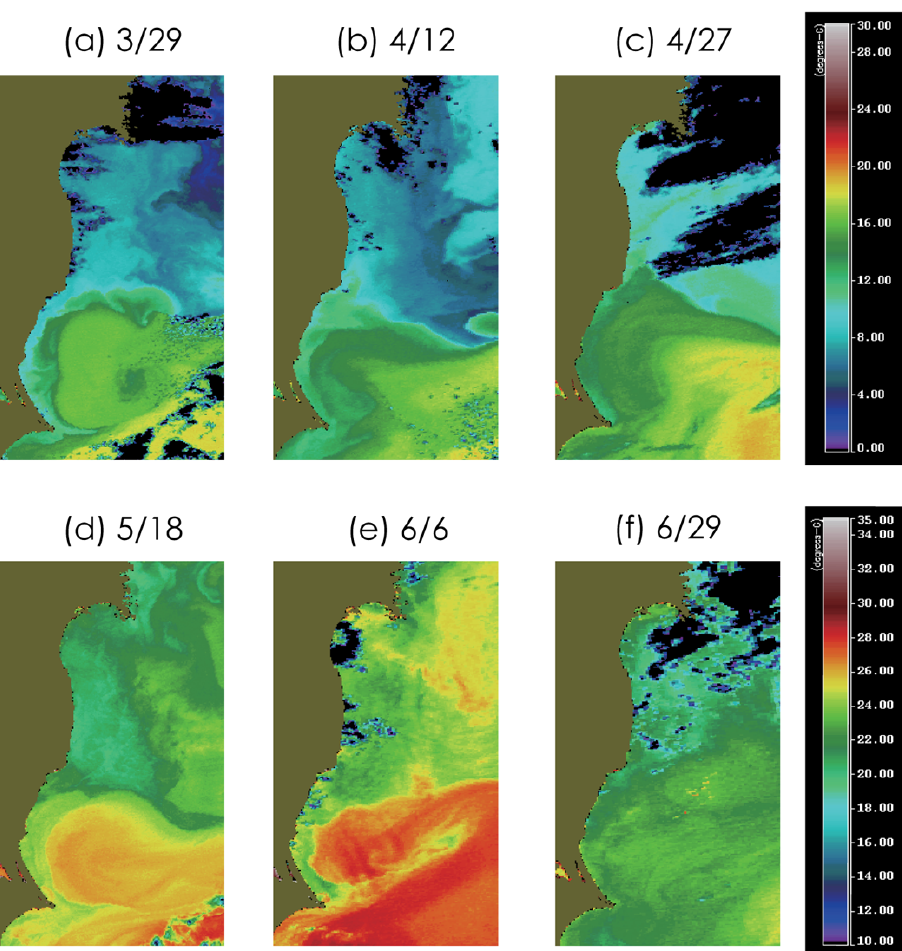
Fig. 5. The SST observed by MODIS from March to June 2011. Dark regions are where clouds exist. Color contours are shown on the top right for (a–e) but bottom right for (f)